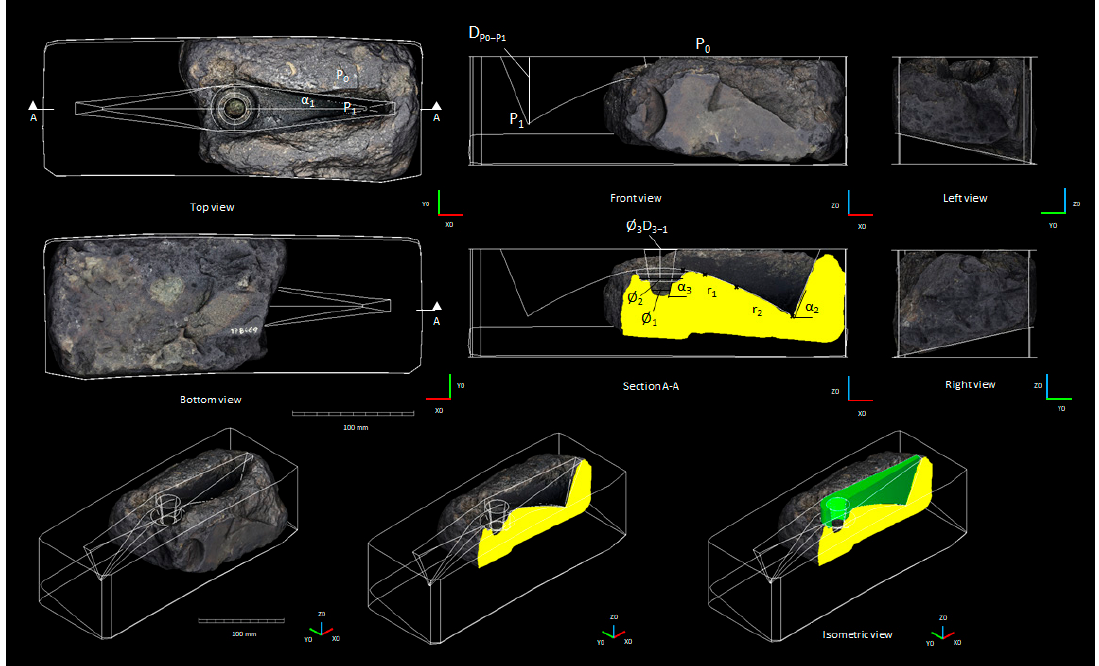
Figure 17. Sorradile mould (S1 3D model): orthoviews, isometric views and sections and dimensional parameters of the mould, oriented according to the worked surfaces. Example of 3D geometric reconstruction of the original shapes and dimensional parameters of the mould (DP 0 − P 1 = mould depth; Dn = mould depth; Ø = diameter of circular shapes; Ømn = average diameter of the circular shapes).